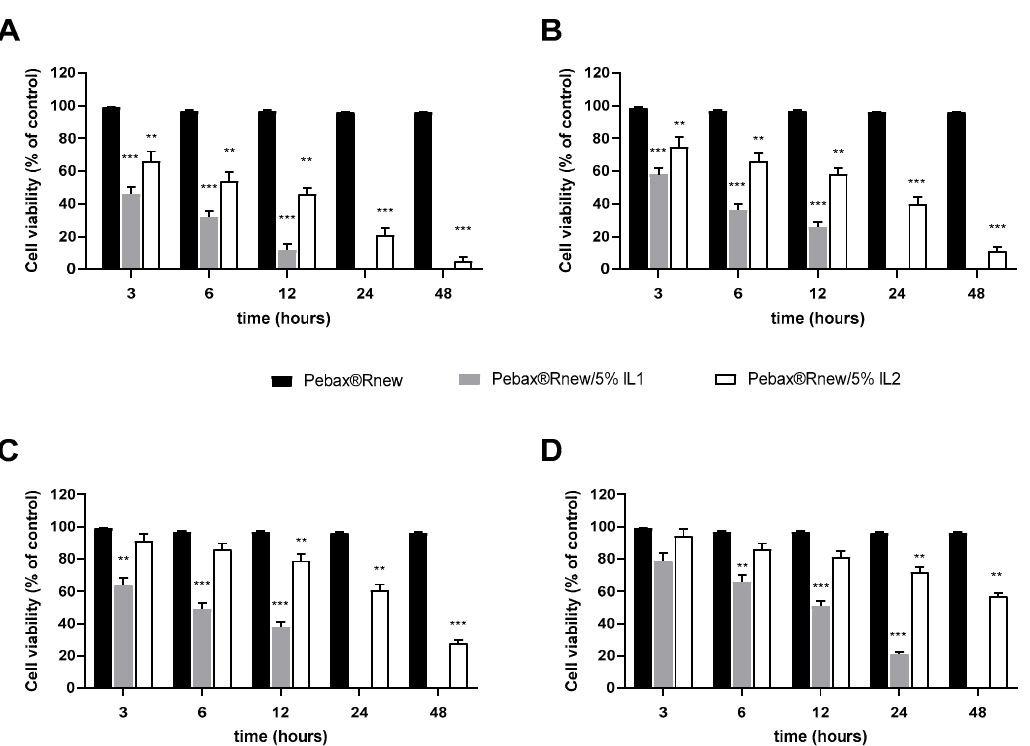
Figure 8. E ff ect of ILs on cell viability. Caco-2 cells were treated with ILs released medium serially diluted by a factor of 10: ( A ) 1, ( B ) 0.1, ( C ) 0.01 and ( D ) 0.001. Cell viability was assessed by CCK-8 assay after 3, 6, 12, 24 and 48 h of incubation at 37 ◦ C. ILs cytocompatibility was expressed as a percentage relative to untreated cells used as control. Data are presented as the mean ± SD for six independent measurements ( n = 6). ** p < 0.01, *** p < 0.001 respect to Pebax ® /Rnew.